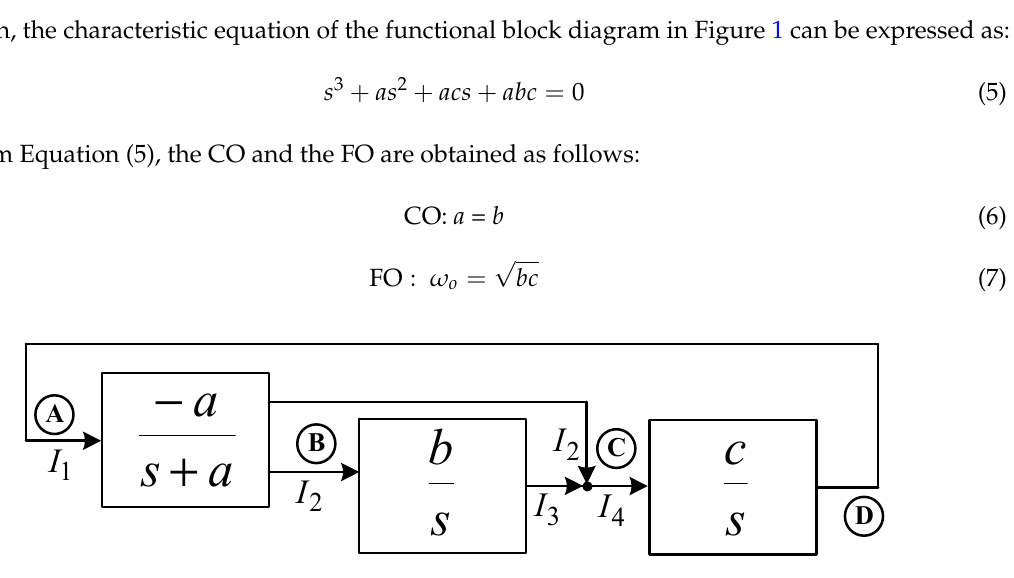
Figure 1. Functional block diagram for realizing third-order quadrature oscillators.